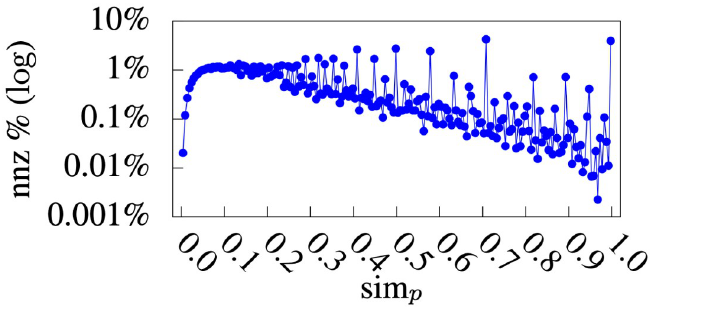
Fig 11. Patient-patient similarity distribution.